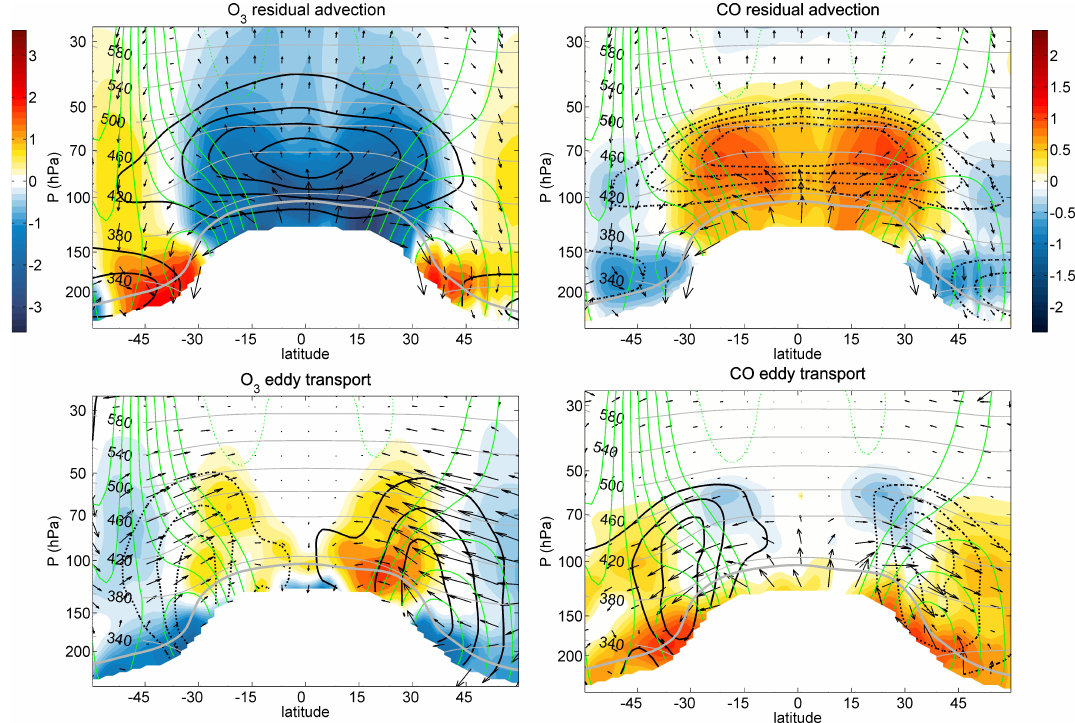
Fig. 7. Annual mean of residual advection (upper panels) and eddy transport (lower panels) for ozone (left) and CO (right) in WACCM, formulated in local percentage tendencies, as in Eq. (4). In upper panels, shading: −¯ v ∗ ln ( ¯ χ) y − ¯ w ∗ ln ( ¯ χ) z , arrows: (cid:0) ¯ v ∗ , ¯ w ∗ (cid:1) , black contours: vertical tracer gradient (dashed: negative, solid: positive). In lower panels, shading: e z/H ∇· M / ¯ χ , arrows: (cid:0) − M y , − M z (cid:1) , black contours: meridional tracer gradient. Units of tracer tendency (shading) are (%day − 1 ) with respect to the annual mean concentration. Green contours show annual mean zonal wind (contour spacing: 5ms − 1 ) . A few annual mean isentropes are shown in gray and labeled. The annual mean lapse rate tropopause is indicated by the thick gray